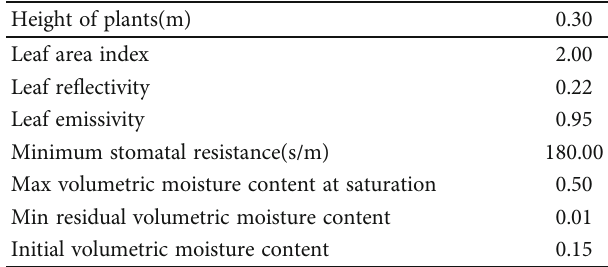
Table 2: Green roof setting.